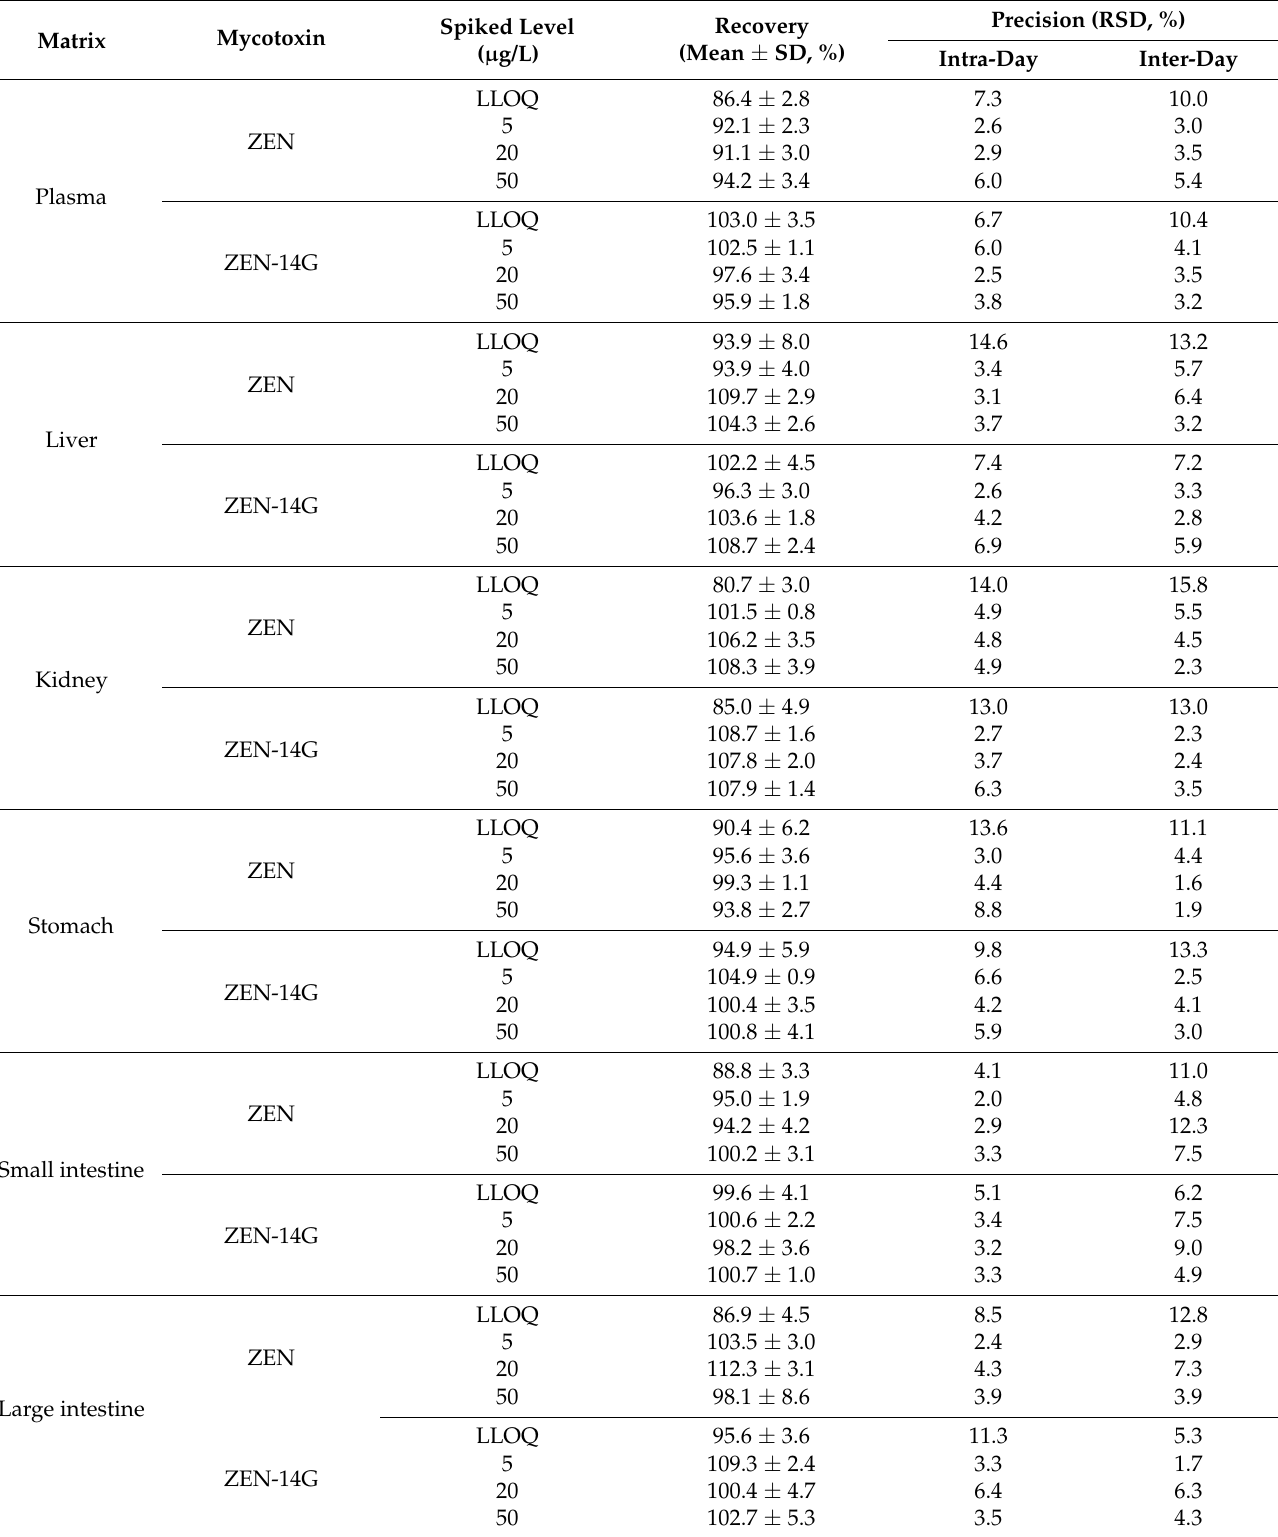
Table 3. Recovery rates, and intra- and inter-day precision of zearalenone (ZEN) and zearalenone- 14-glucoside (ZEN-14G) ( n =